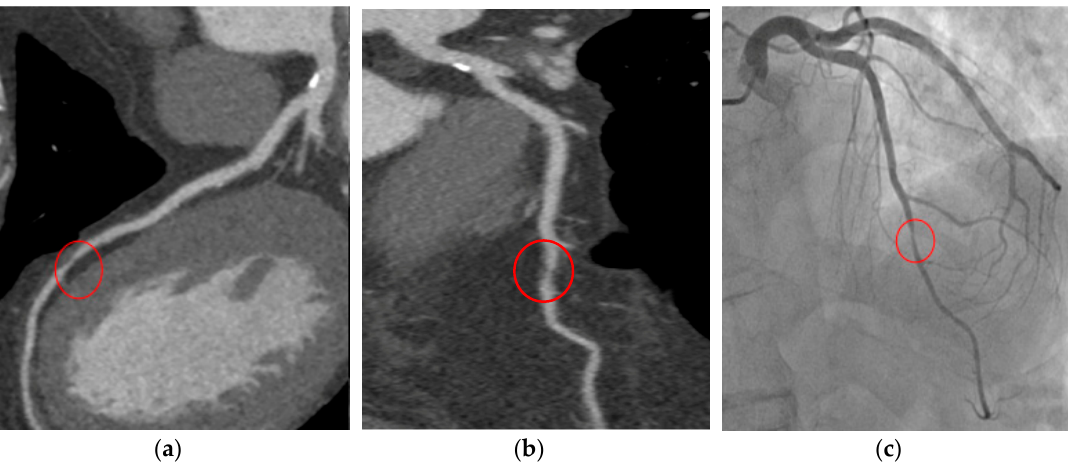
Figure 1. T.F. 67 years-old, male; dyslipidaemia, smoker; typical exertional chest pain; exercise test negative; CCTA ( a,b ): subocclusive stenosis of mid-LAD; ICA ( c ): significant stenosis was confirmed and elective PCI was performed. CCTA: coronary computed tomography angiography; LAD: left anterior descending artery; ICA: invasive coronary angiography; PCI: percutaneous coronary intervention.